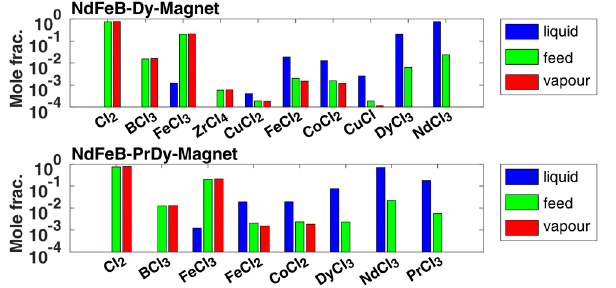
Figure 6. First pre-separation by cooling and pressure release, simplified and calculated as isothermal flash evaporation, as explained in [28]: Upper part : Composition from [9] for the generalized NdFeB-Dy magnet example (first feed example given in [9]) within a maximum deviation of a component of 0.8% lower limit and 1.3% upper limit. The components neodymium and dysprosium trichloride show the highest deviation values. Lower part : Composition from [24] of the first given NdFeB-DyPr magnet example within a maximum deviation of a component of 0.9% lower limit and 1.2% upper limit. The component neodymium trichloride shows the highest deviation values.